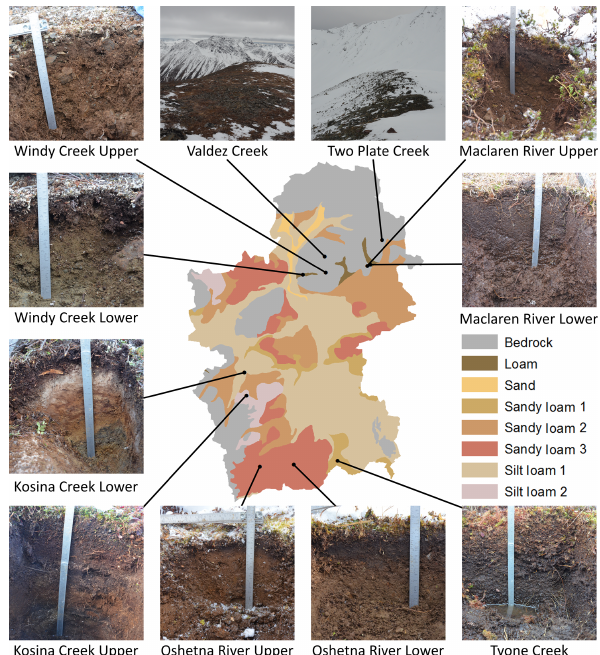
Figure 16. Photos of shallow soil pits. The map shows STATSGO soil type boundaries and pit locations. The ruler in each photo is 1.5cm wide. Pit depths range from about 10 to